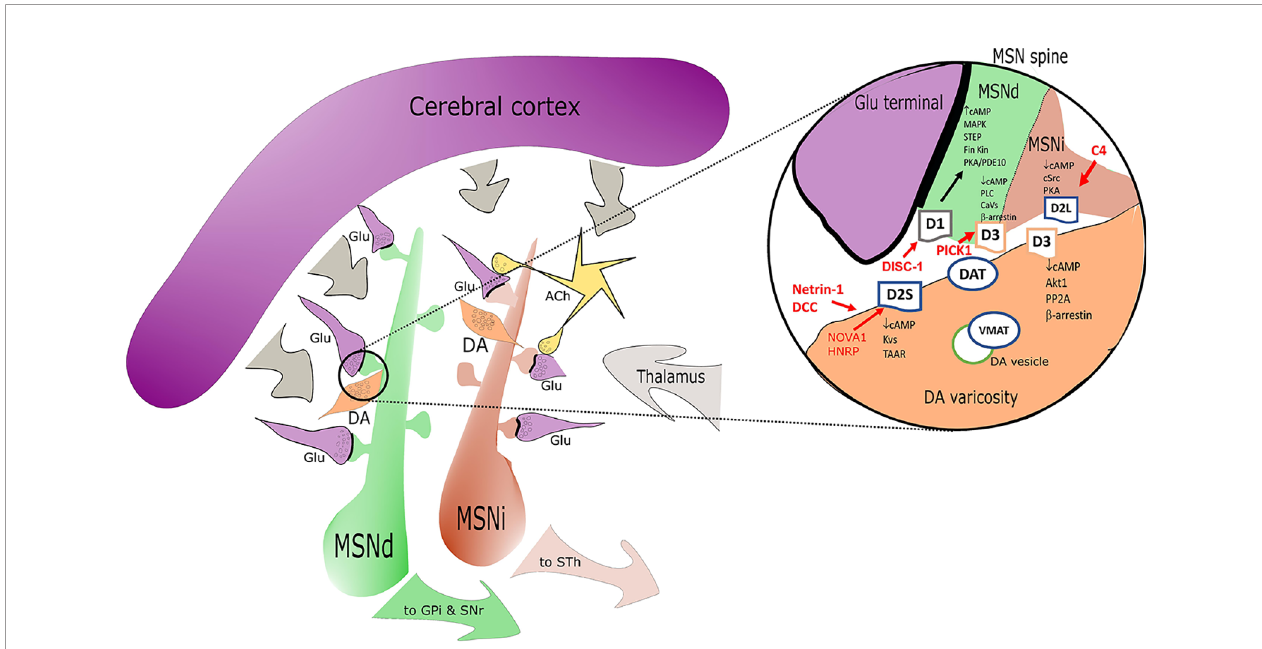
FIGURE 1 | Simpli fi ed sketch of the dopamine receptors (DR) connectome in the basal ganglia/striatum with a zoom (right circle) on signal transduction at presynaptic level in medium spiny neurons (MSN) dendritic boutons. Highlights on the elements associated with SCZ alterations are depicted in red. D1 positive medium spiny neurons of the direct pathway (MSNd) are in green, inhibitory D2 positive MSN of the indirect pathway (MSNi) are in red. Glutamatergic cortical input - presynaptic terminals are in magenta. DA “ en passant ” boutons are indicated in orange and in close proximity of glutamatergic postsynaptic spines. Cholinergic interneurons are in yellow. In the magni fi cation on the right note the distribution of DR: D2s and D3 are presynaptic in DA terminals; D1/D3 postsynaptic in MSNd and D2L postsynaptic in MSNi. Other projections are in gray. Abbreviations: ACh, acetylcholine; DA, dopamine; Glu, glutamate; MSNd/i, direct/ indirect path projecting MSN neurons; GPi, internal segment of globus pallidus; SNr, substantia nigra, reticular part; STh, subthalamic nucleus; other common abbreviation and protein names as cited in